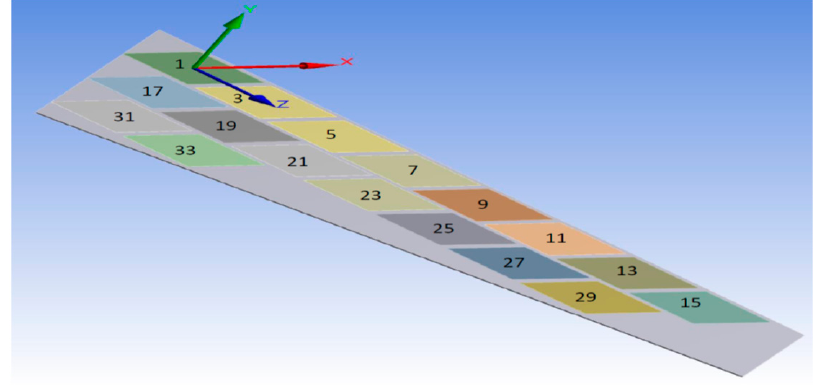
Figure 17. FE model of sweptback wing showing numbered MFC actuators and their coordinate system.